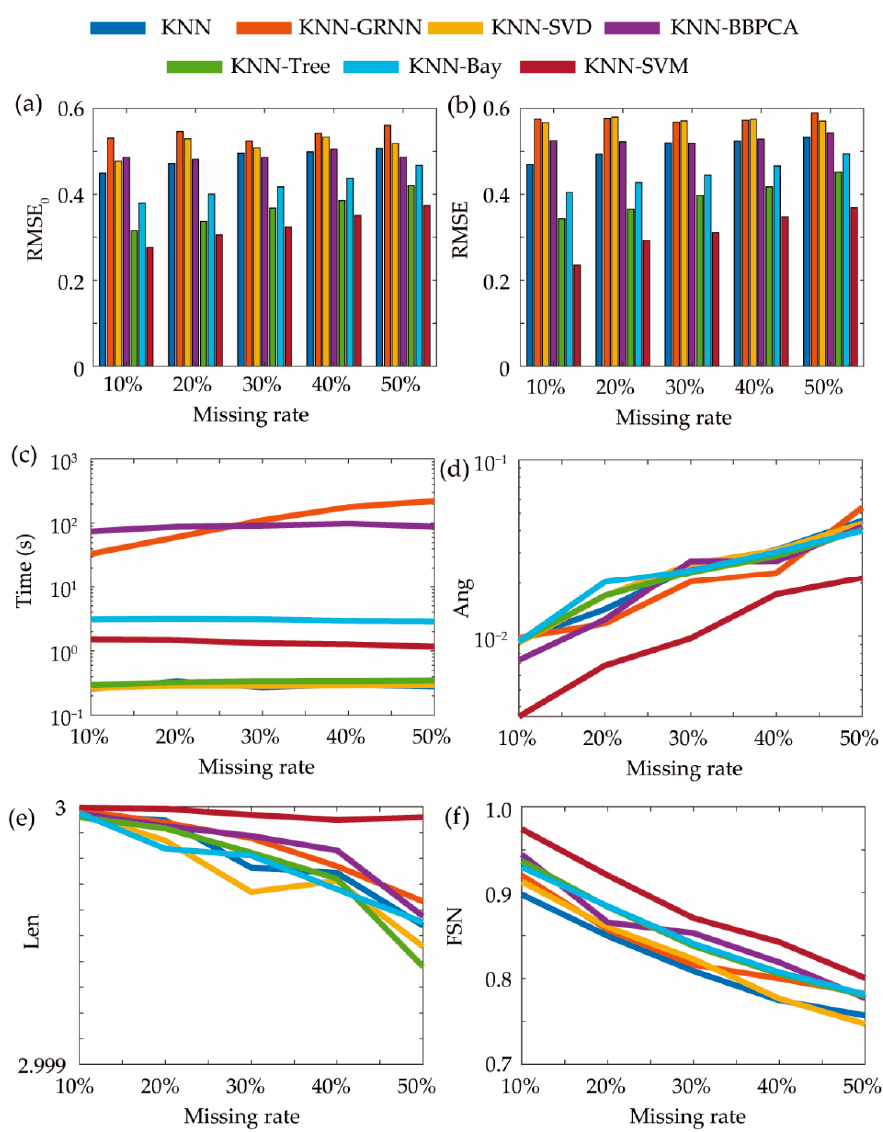
Figure 6. Performance of different composite methods to predict the missing values in FR ( a ) RMSE of categorical variables; ( b ) RMSE; ( c ) computation time; ( d ) Ang; ( e ) Len; ( f ) FSN.